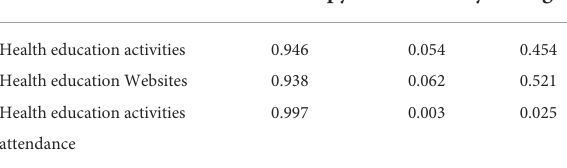
TABLE 1 Comprehensive evaluation index system for health